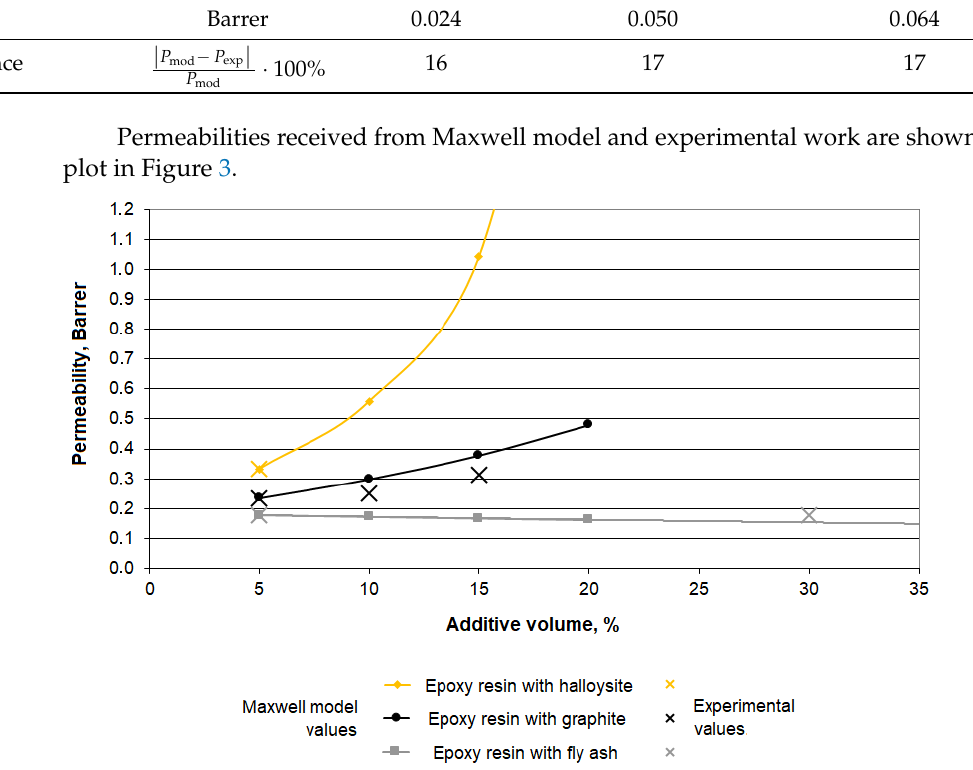
Table 4. Hydrogen permeability obtained in experimental methods [26,32].